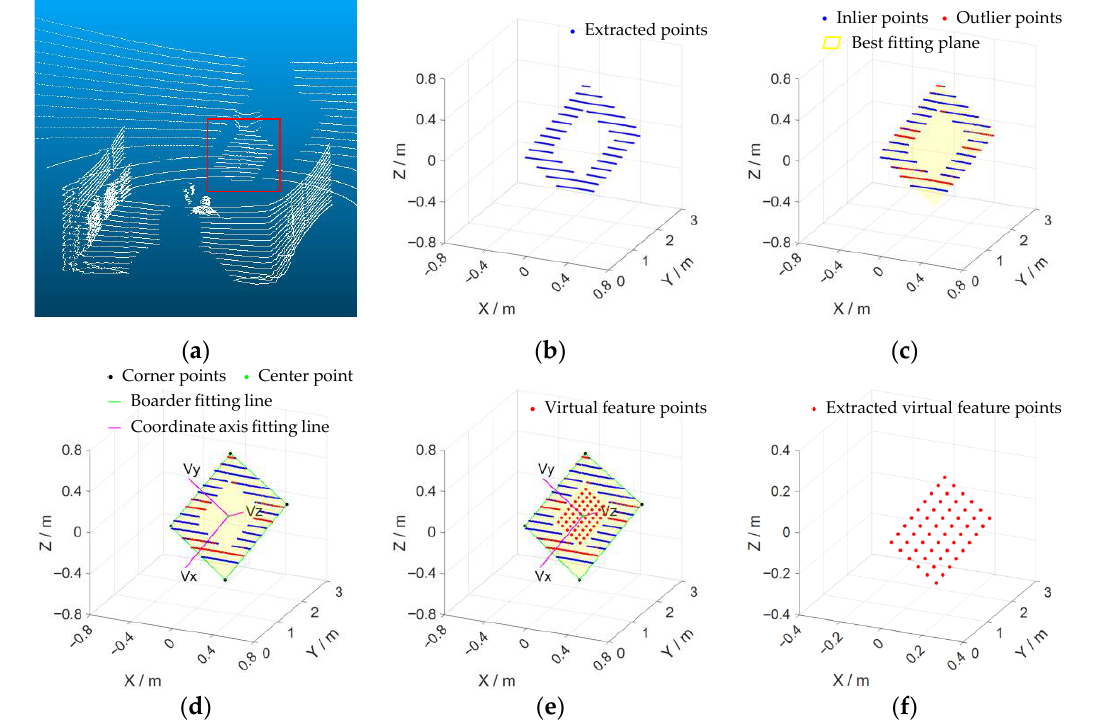
Figure 3. Virtual feature corner extraction process, from ( a - f ). ( a ) Original point cloud; ( b ) extract the point cloud on the calibration board according to the intensity; ( c ) fit the plane of the calibration board; ( d ) fit the edge of the calibration board, and determine the calibration board coordinate system; ( e ) fit virtual feature corner points; ( f ) get virtual feature corner points.